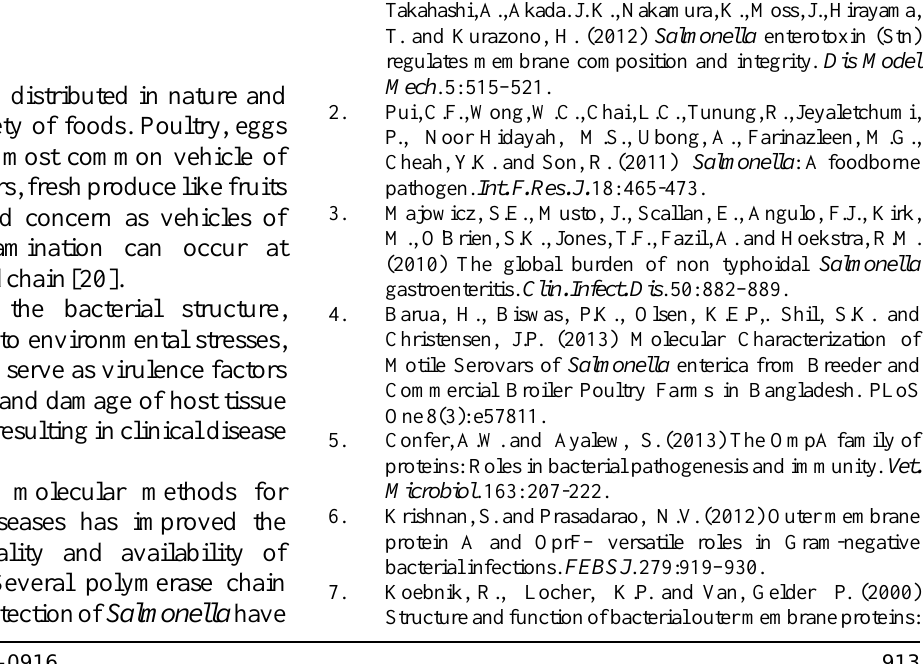
Figure-1. Sensitivity of OmpA PCR after tenfold dilution of genomic DNA of S